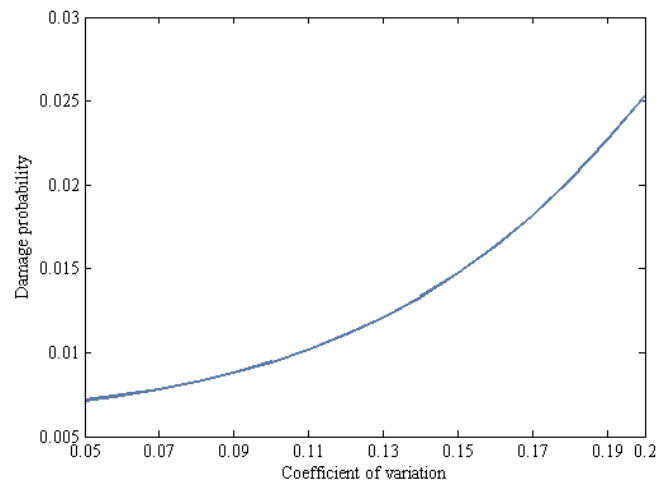
Figure 5. Relationship curve between the coefficient of variation and the damage probability. 329